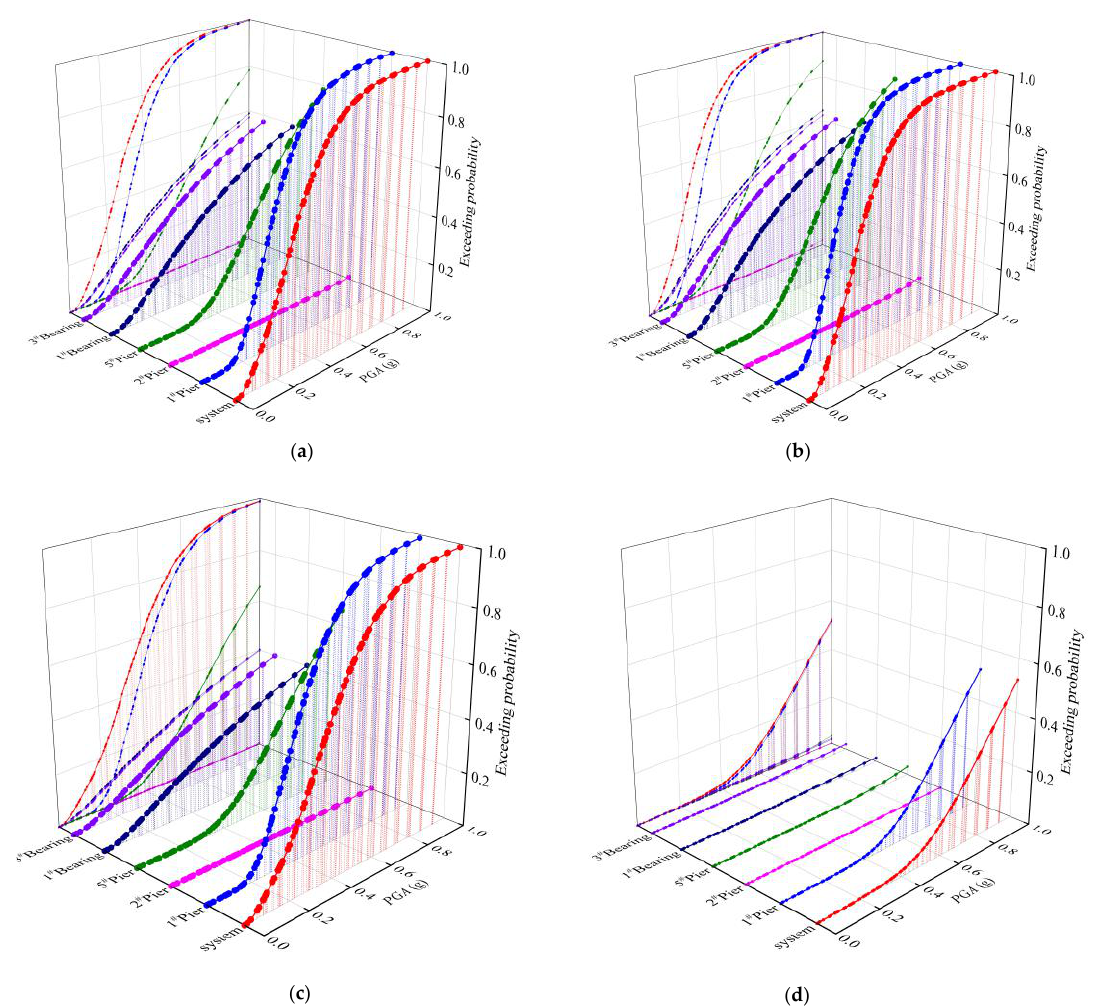
Figure 10. Fragility curves of each representative component and the bridge system: ( a ) Slight damage; ( b ) Moderate damage; ( c ) Extensive damage; ( d ) Complete